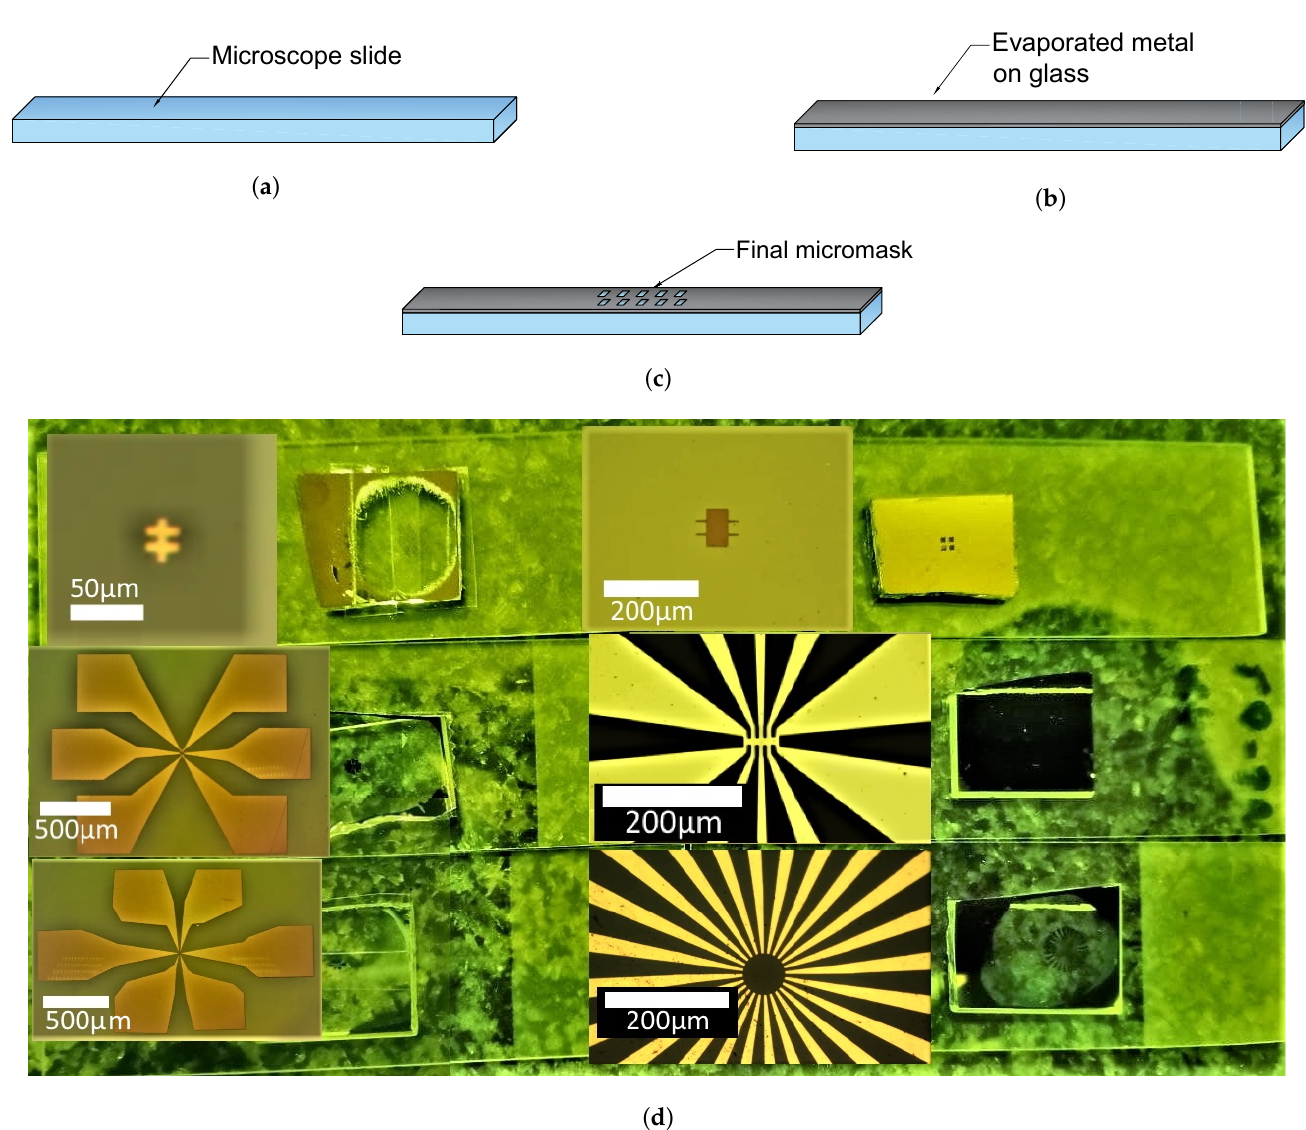
Figure 2. Fabrication of masks based on a microscope glass slide. ( a ) glass; ( b ) evaporated chromium layer on the slide; ( c ) etched mask after optical lithography; ( d ) some of our masks for mesa-structures and